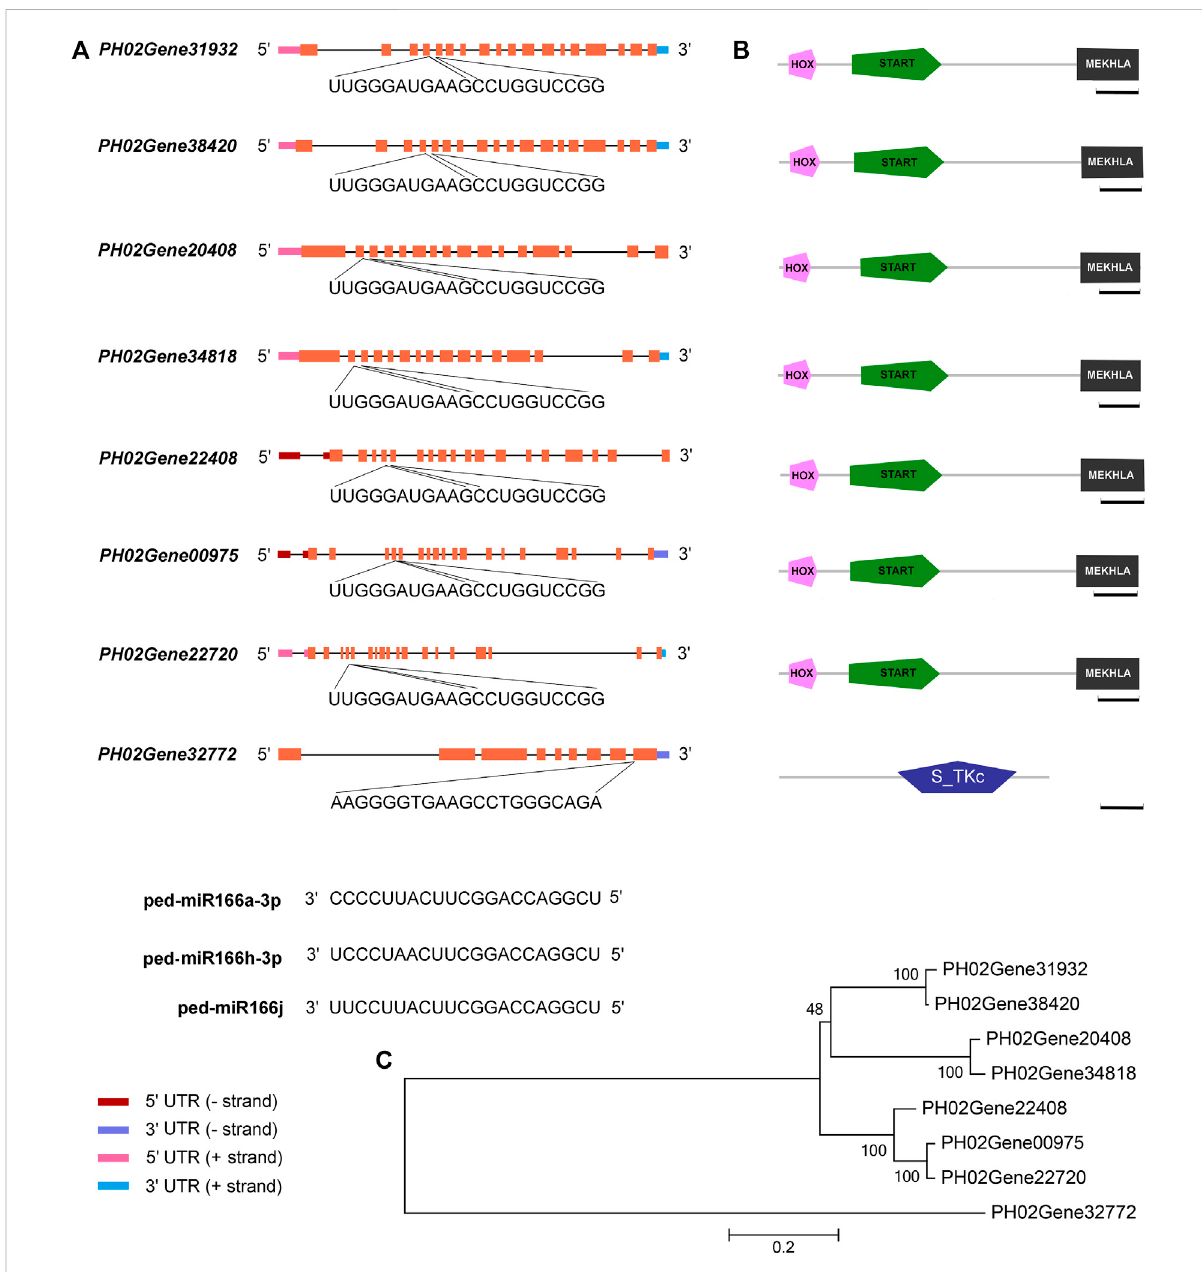
FIGURE 5 miR166s and their predicted targets in Moso bamboo. (A) Sequences of three miR166s, seven HD-ZIP III genes, and a protein kinase gene. (B) HD-ZIP III genes encode proteins with the following domains: an N-terminal MEKHLA domain, a START domain, and a C-terminal HOX domain. (C) Relationships among eight target genes. Diagrammatic representation of the target genes. Exons correspond to boxes, and introns correspond to lines. The HOX, START, and MEKHLA domains are the three structural domains in the coding sequences. Following them are the sequences of the binding sites in the eight targets and miR166s. Bar = 100 amino